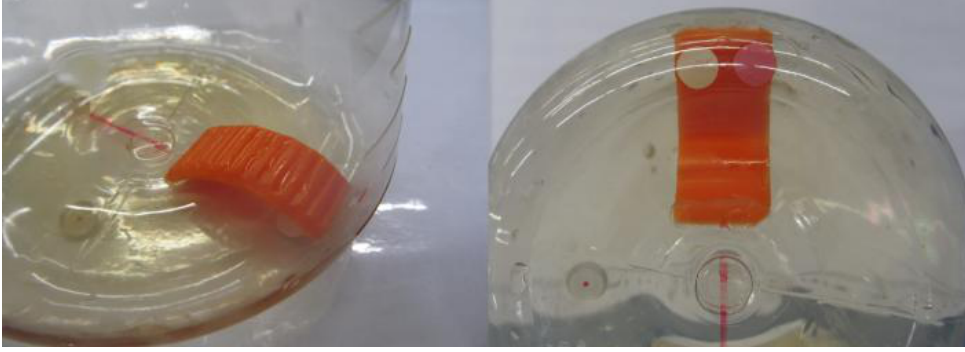
Figure 1. Positioning of the light shade on the bottom of a corning non-baffled 500 mL disposable shake flask. White dot = pH sensorspot, reddish dot = oxygen